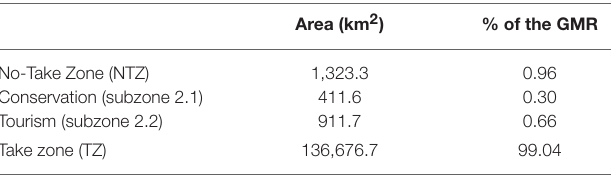
TABLE 1 | Comparison of No-Take Zones and Take Zones within the Galapagos Marine Reserve according to the Zoning Plan 2000. Area (km 2 ) % of the GMR No-Take Zone (NTZ) Conservation (subzone